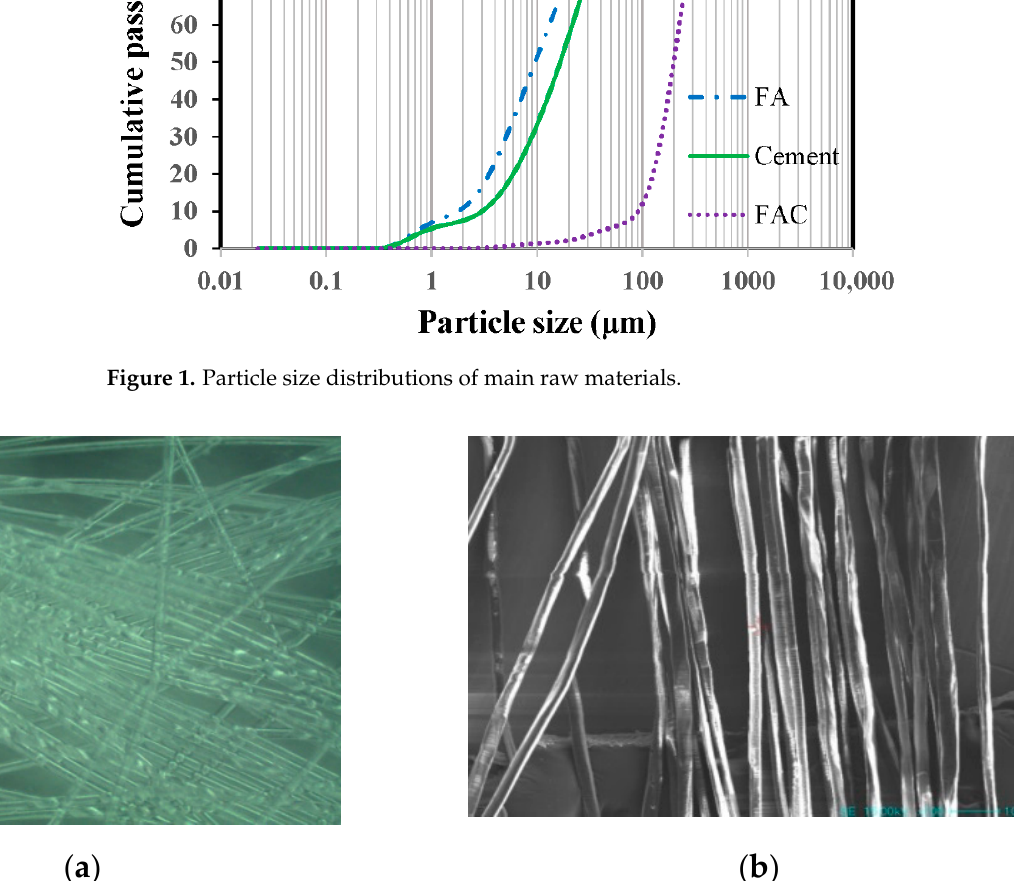
Figure 1. Particle size distributions of main raw materials. Table 2. Physical and mechanical performances of PE fibers.